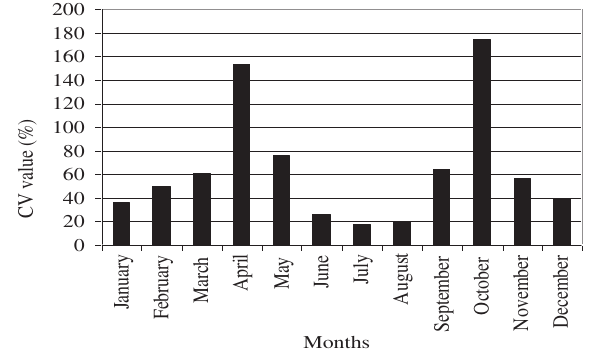
Figure 3 – The mean values of coeffi cients of variation (CV) of the mean absolute monthly minimum temperatures measured at 16 stations over a period of 1951–2010